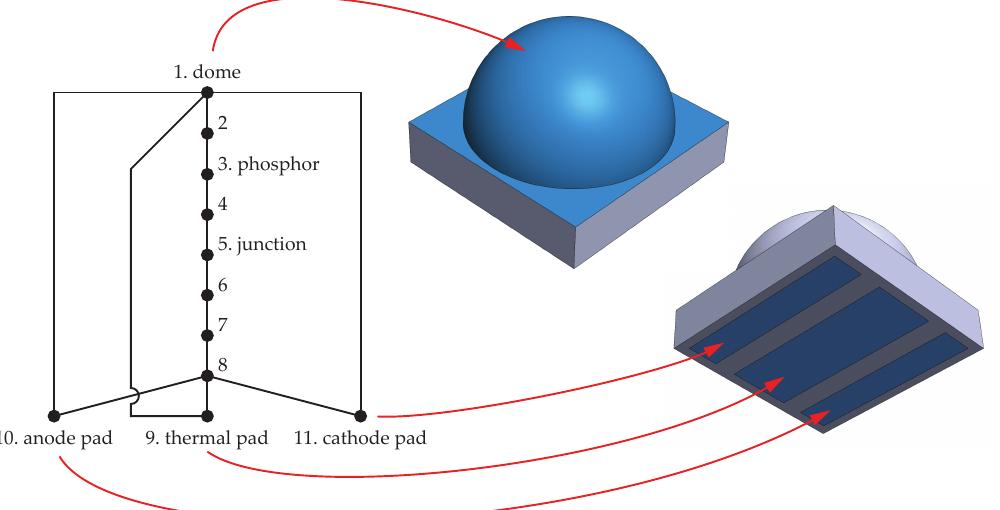
Figure 3. RC-network topology of the LED CTM ( left ), and two isometric views of the simplified 3D geometry of the LED CTM ( right ). The red arrows indicate to which surfaces (in blue) the temperatures of the peripheral nodes of the RC-network model are